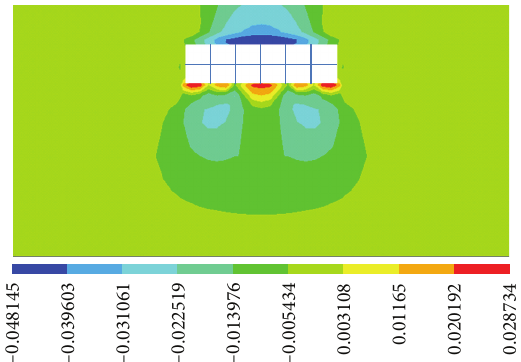
Figure 2: Vertical displacement nephogram of Method 2.